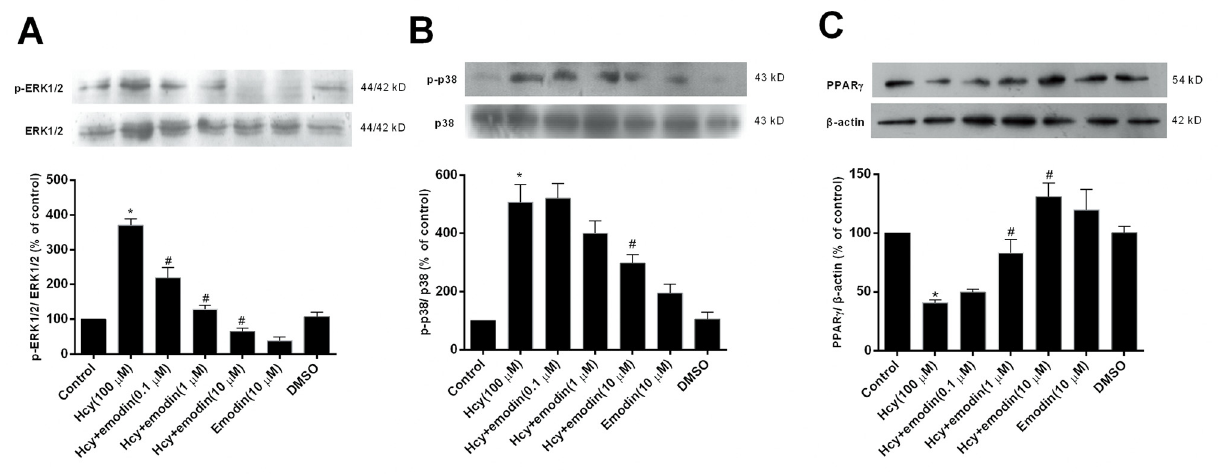
Fig 3. Effects of emodin on Hcy-activated ERK1/2 and p38 phosphorylation and Hcy-restrained PPAR γ expression in VSMCs. After pretreatment with the different concentrations of emodin for 24 h, the cells were stimulated with 100 μ M homocysteine (Hcy) for 1 h for ERK1/2 and p38 phosphorylation, and for 12 h for PPAR γ expression. Then, ERK1/2 (A) and p38 (B) phosphorylation and PPAR γ protein expression (C) were detected by Western blot. Emodin alone was used as drug control and DMSO (0.1%) was used as solvent control. Results from three independent experiments were expressed as means ± S.E.M. * P < 0.05 vs . control, # P < 0.05 vs . Hcy alone.